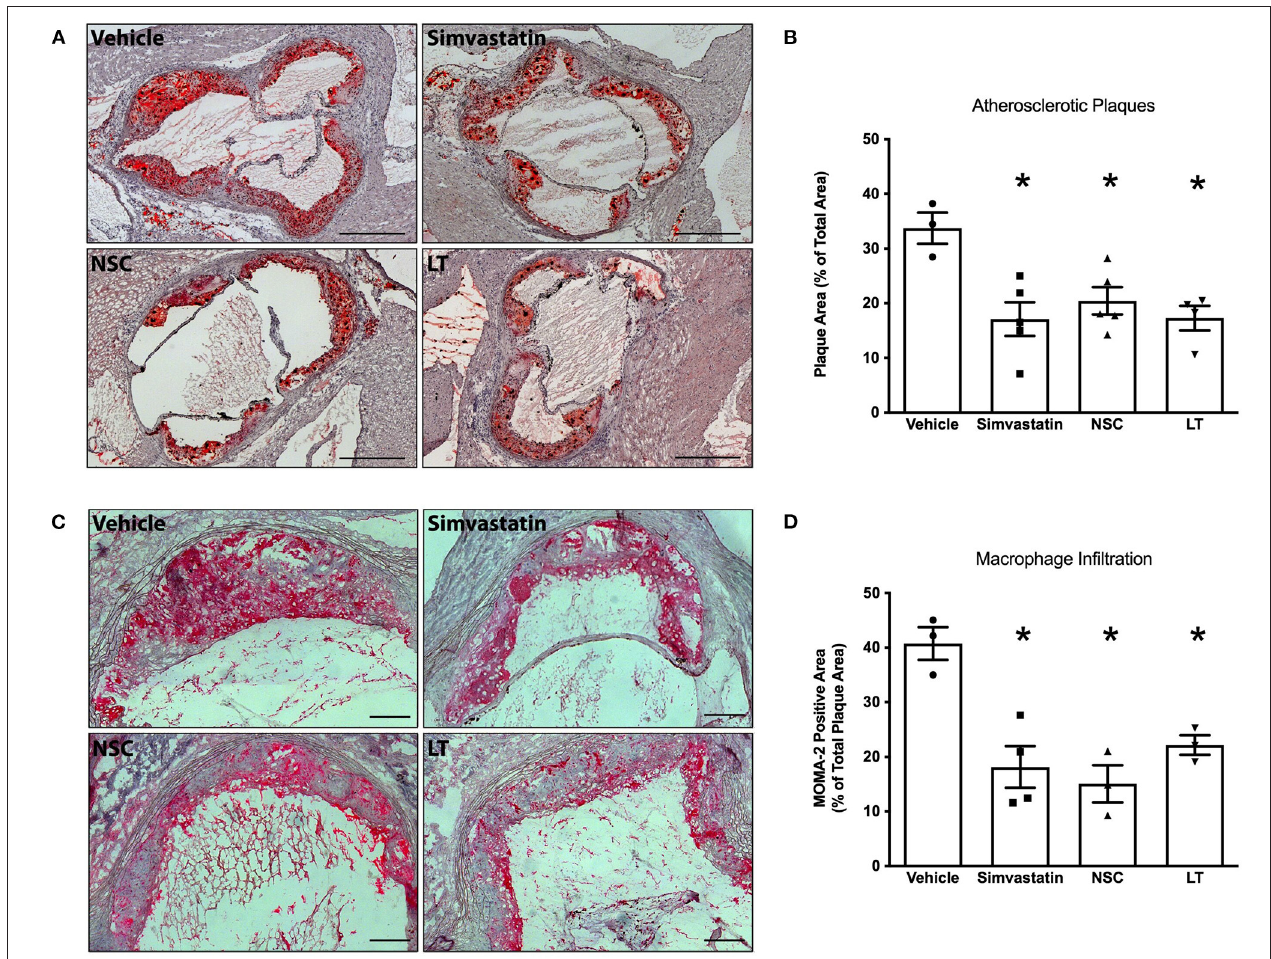
FIGURE 5 | Vascular effects of different Rac1 inhibitors: atherosclerosis and macrophage infiltration. ApoE − / − mice were fed a cholesterol-rich diet for 7 weeks and were concomitantly treated with vehicle, LT (0.1 µ g LT/week), NSC 23766 (10 mg/kg/d), or simvastatin (20mg activated simvastatin/kg/d). All three compounds significantly reduced atherosclerotic plaque formation in the aortic root compared to vehicle-control. (A) Representative histological cross-sections. Scale bars indicate 0.5mm. (B) Quantification of atherosclerotic plaque formation, expressed as plaque area in percent of total area (* p < 0.05 vs. vehicle, n = 3–5 per group). Furthermore, all three compounds significantly reduced macrophage infiltration of atherosclerotic plaques in these mice. (C) Representative MOMA-2 immunohistochemical staining using a monoclonal rat anti-mouse MOMA-2 antibody. Scale bars indicate 0.15mm. (D) Quantification of macrophages infiltrating aortic atherosclerotic plaques (* p < 0.05 vs. vehicle, n = 3–4 per